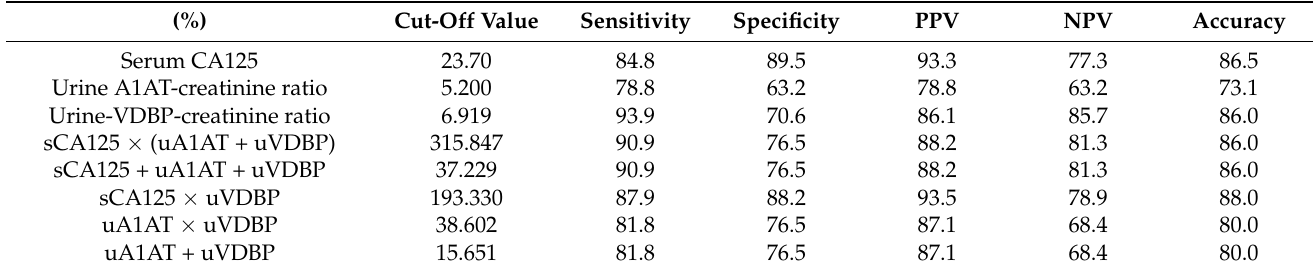
Table 4. The sensitivity, specificity, positive predictive value, negative predictive value, and accuracy of different biomarkers for